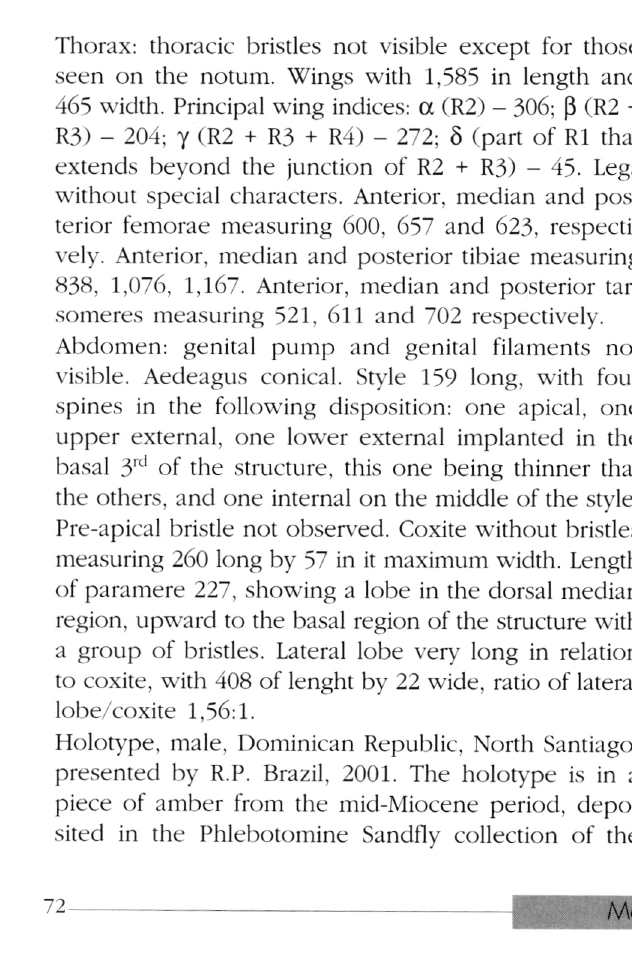
Fig. 1. - Trichopygomyia killickorum sp. n., holotype, Dominican amber. Scale = 100 p.